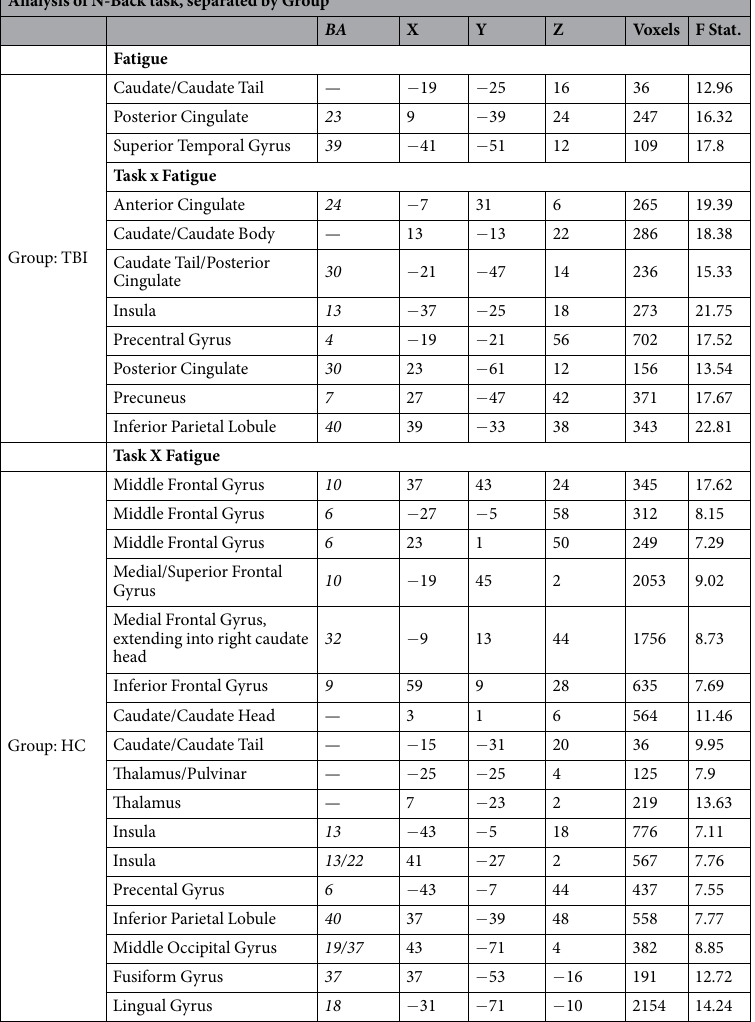
Table 2. Areas of significant brain activation for the analysis the N-Back task, separately for each Group. ‘BA’ denotes Broadman’s Area; ‘X’, ‘Y’, and ‘Z’ denote the location in Talairach space of the voxel in the cluster with the highest activation; ‘Voxels’ denotes the number of voxels in each cluster; ‘F-Stat.’ denotes the F-statistic associated with the voxel of highest